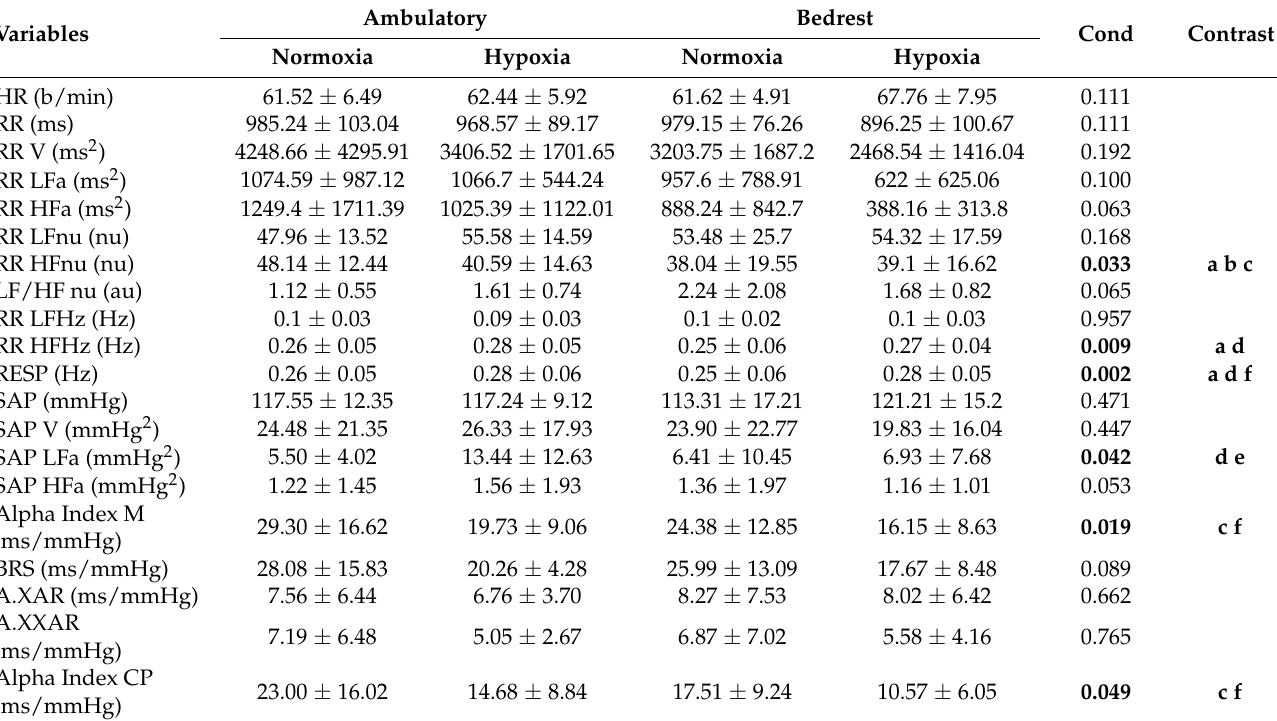
Table 2. Descriptive statistics of the main RR and SAP variability variables in the four considered